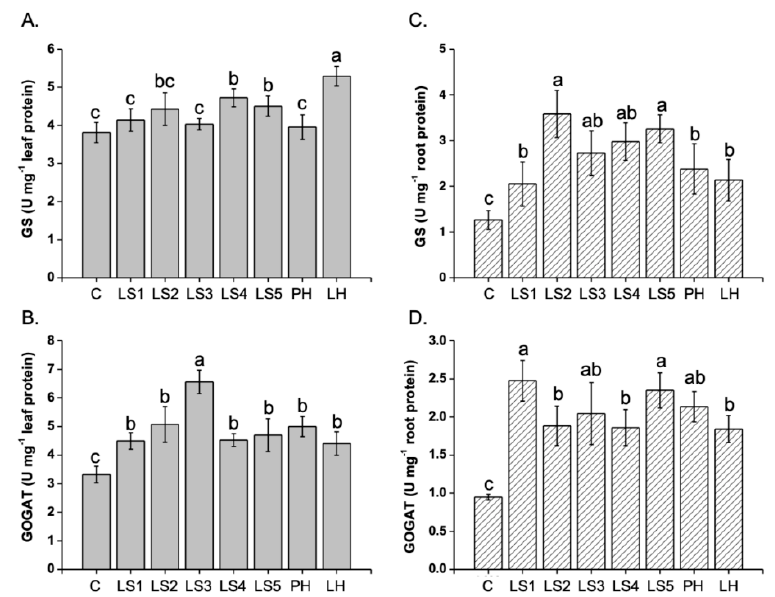
Figure 5. E ff ect of humates (Hs) on glutamine synthetase (GS) and glutamate synthase (GOGAT) activity in leaves ( A , B , respectively) and roots ( C , D , respectively) of Z. mays L. plants. Twelve-day-old plants were supplied with Hs at 1 mg C L − 1 for two days. Di ff erent letters above bars indicate significant di ff erences at p < 0.05, according to the Student–Newman–Keuls test. Data represent the means of three measurements with three plants in each ( ± SD). C = control; LH = commercial lignosulfonate-based product; PH = commercial humate extracted from leonardite; LS1 − LS5 = specialty lignosulfonates.